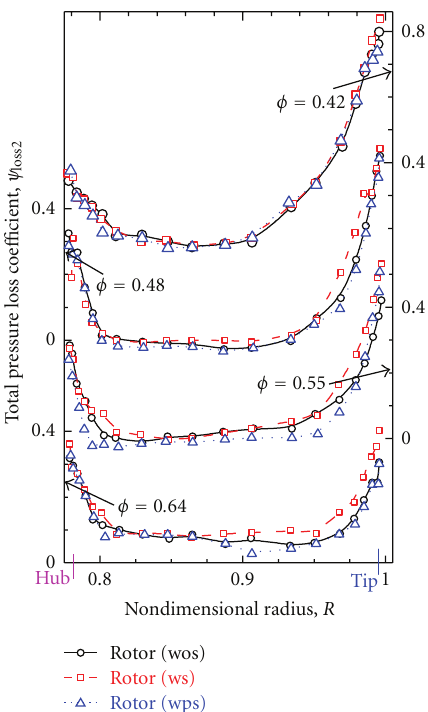
Figure 7: Radial distribution of total pressure loss coe ffi cient at the rotor